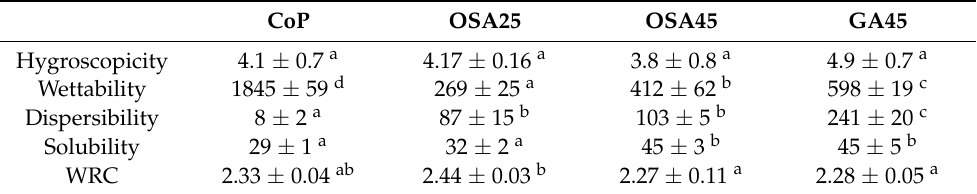
Table 7. Hygroscopicity (g water gained/100 g dry solutes), wettability (s), dispersibility (g dry solutes passing through the sieve/g dry solutes sample), solubility (%), and water retention capacity (WRC, %) of the different powder samples (codes according to Table 1). CoP